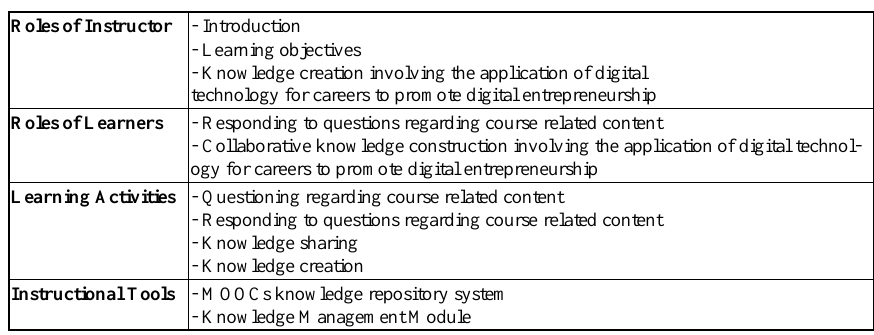
Table 1. Knowledge